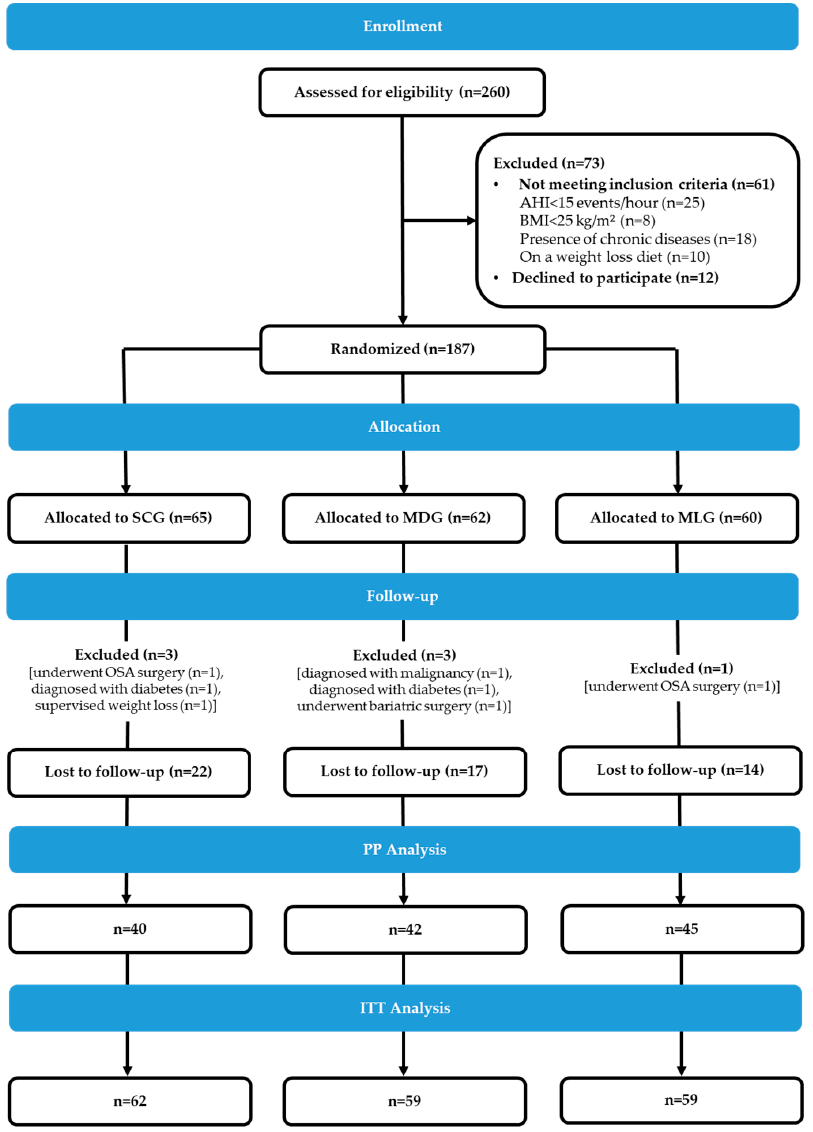
Figure 1. Trial flow diagram. From September 2015 to January 2019, 385 patients were